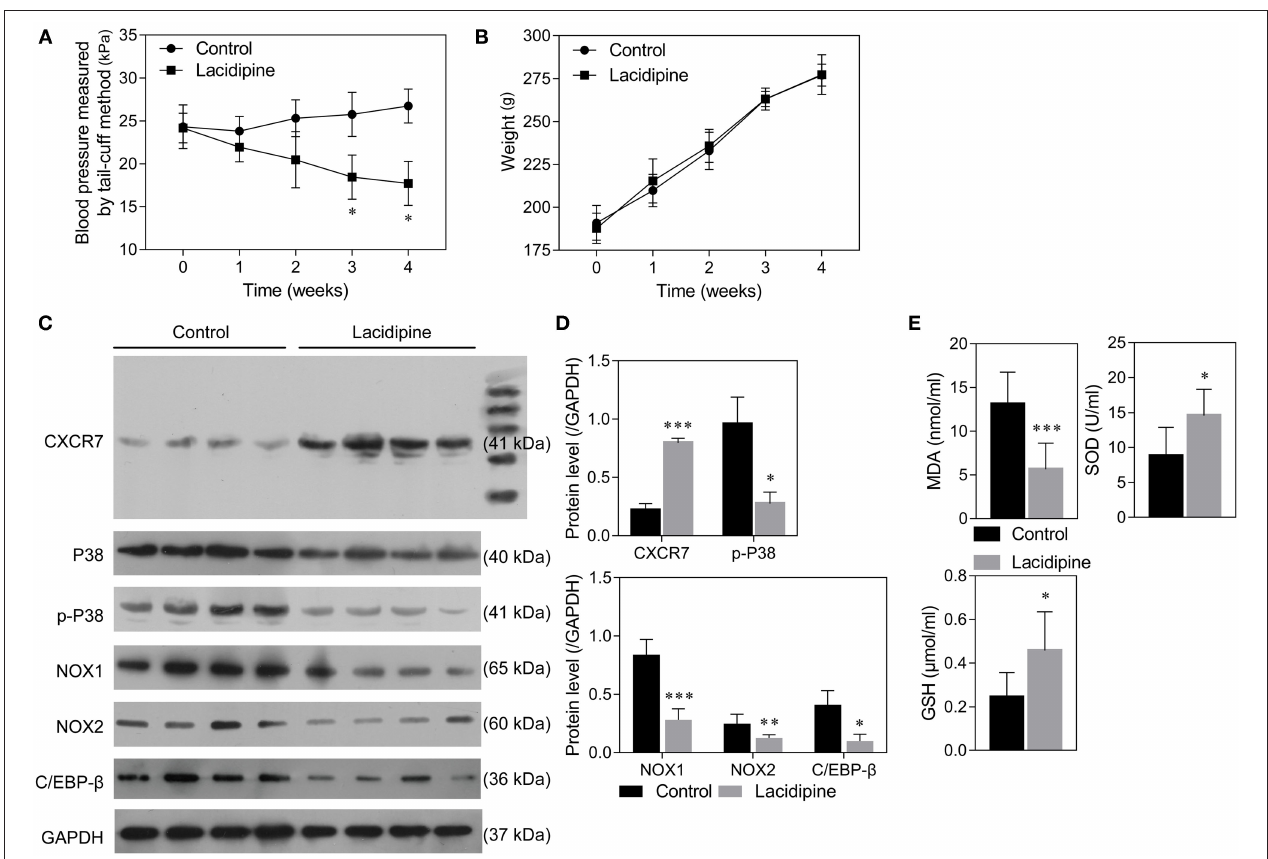
FIGURE 1 | Lacidipine attenuated arterial hypertension and regulated CXCR7/P38/C/EBP- β expression in vivo . Blood pressure of spontaneously hypertensive rats (SHRs) treated with and without Lacidipine was measured by the tail-cuff method (A) . (Data are mean ± SD, n = 8 in each group). The weight of SHRs in the control and Lacidipine groups (B) . Western blot was performed to analyze the protein expression of CXCR7, P38, p-P38, C/EBP- β , NOX1, and NOX2 in the aortic tissues from the control and Lacidipine groups (C,D) . The levels of MDA, SOD, and GSH in serum were measured by ELISA assays (E) . ( * p < 0.05, ** p < 0.01, *** p < 0.001, compared with the control